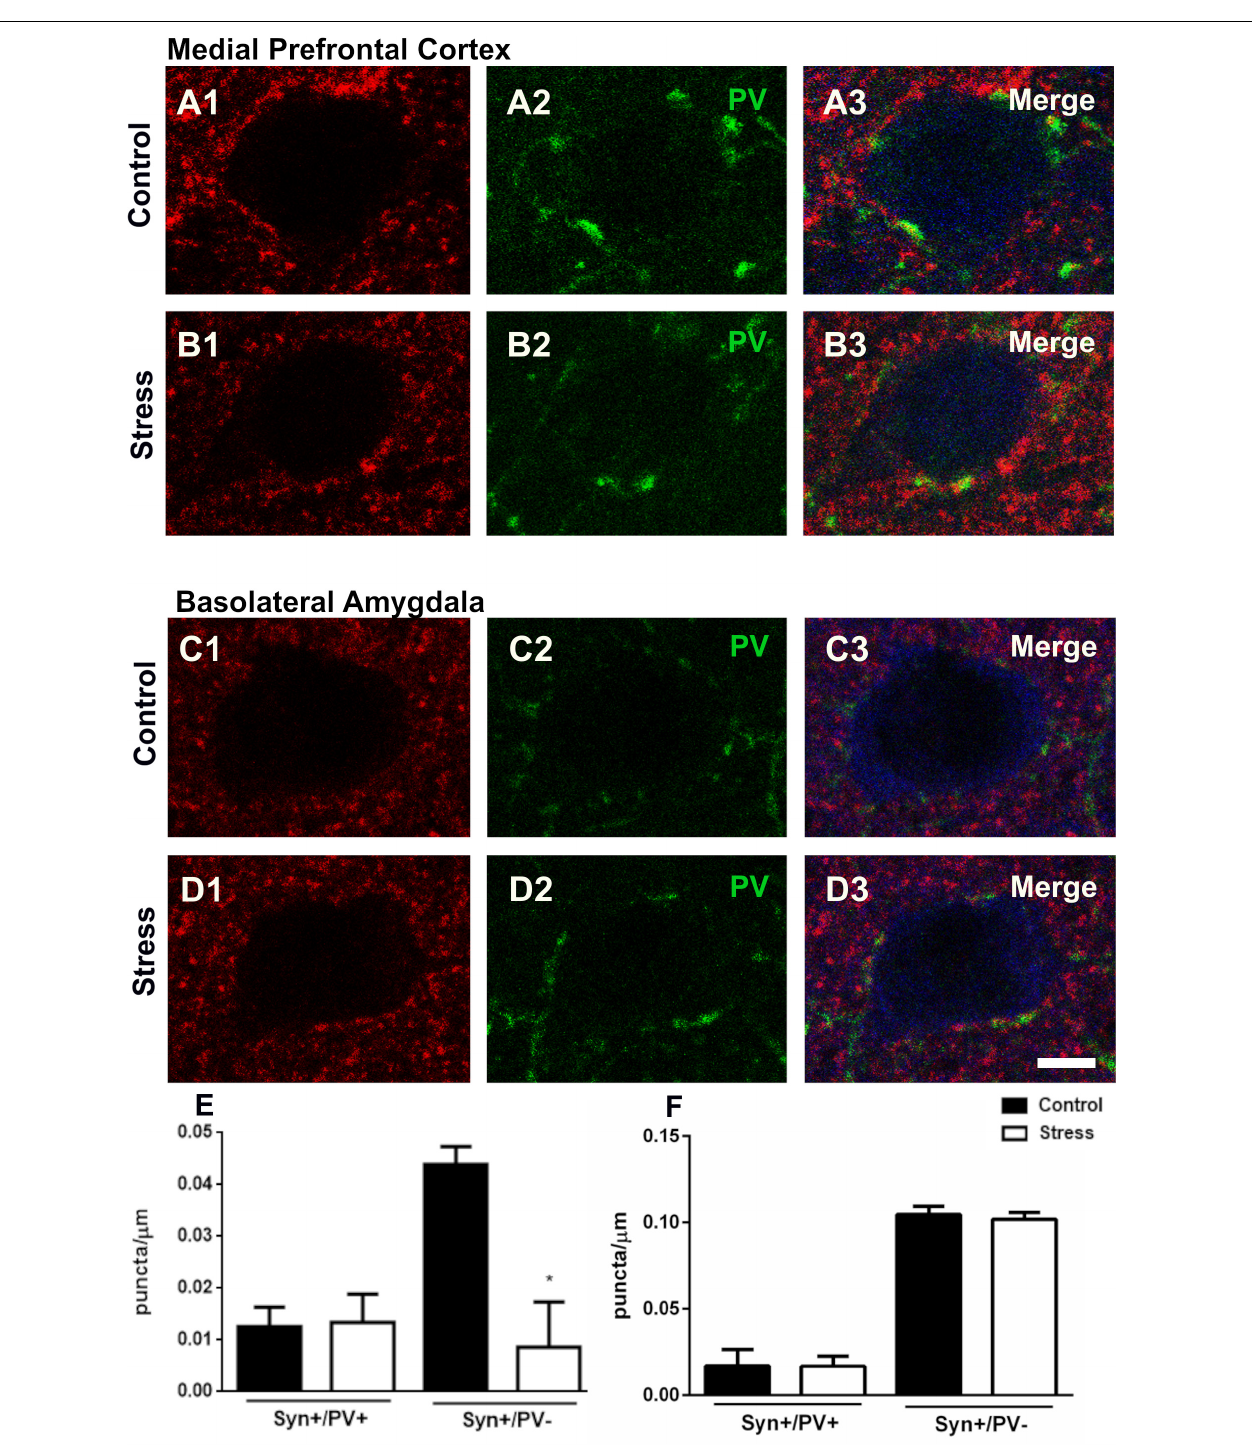
FIGURE 4 | Confocal microscopic analysis of parvalbumin (PV) and synaptophysin (SYN) expressing puncta in the perisomatic region of excitatory neurons in the mPFC and basolateral amygdala in control rats and after 10 days of chronic restraint stress. Single confocal planes of principal neuron somata (immunolabeled for CaMKII- α ; blue) showing perisomatic puncta immunoreactive for SYN ( A1–D1 ; red) and PV ( A2–D2 ; green) and their colocalization (A3–D3) in the mPFC (A,B) and the basolateral amygdala (C,D) . Graphs on the bottom of the figure show changes in the linear density (number of puncta/ µ m of soma perimeter) of synaptophysin expressing perisomatic puncta with (Syn + /PV + ) or without (Syn + /PV–) PV coexpression ( E : mPFC; F : BLA). Values represent mean ± S.E.M. Asterisks indicate statistically significant differences between groups (Control × Stress) after unpaired Student’s t -test ( ∗ p < 0.05). Scale bar 5 µ m.